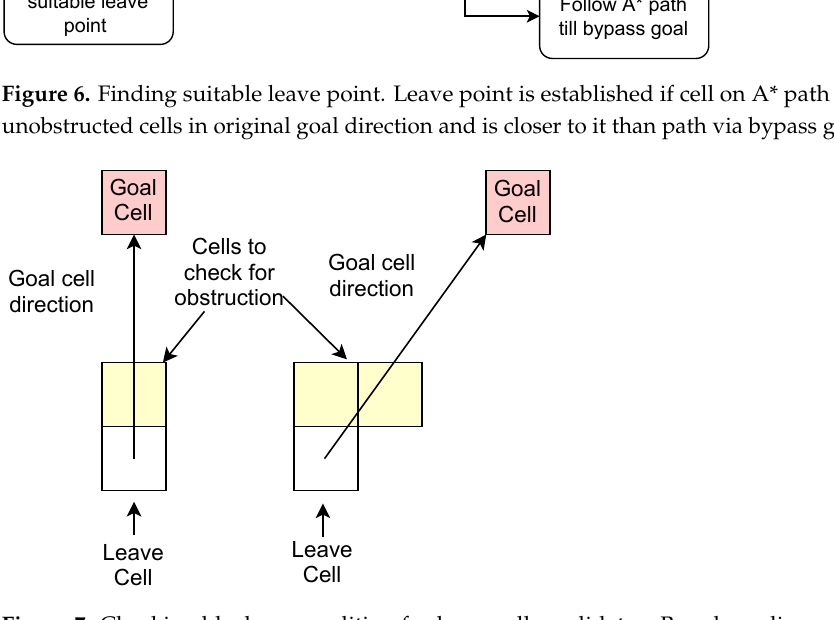
Figure 7. Checking blockage condition for leave cell candidates. Based on alignment of potential leave cell with original goal cell, occupancy status of either one or two cells is checked to determine whether obstruction is